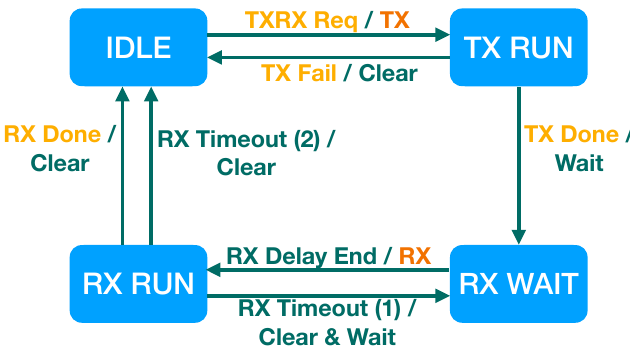
Figure 6. The LPHY FSM for the class A